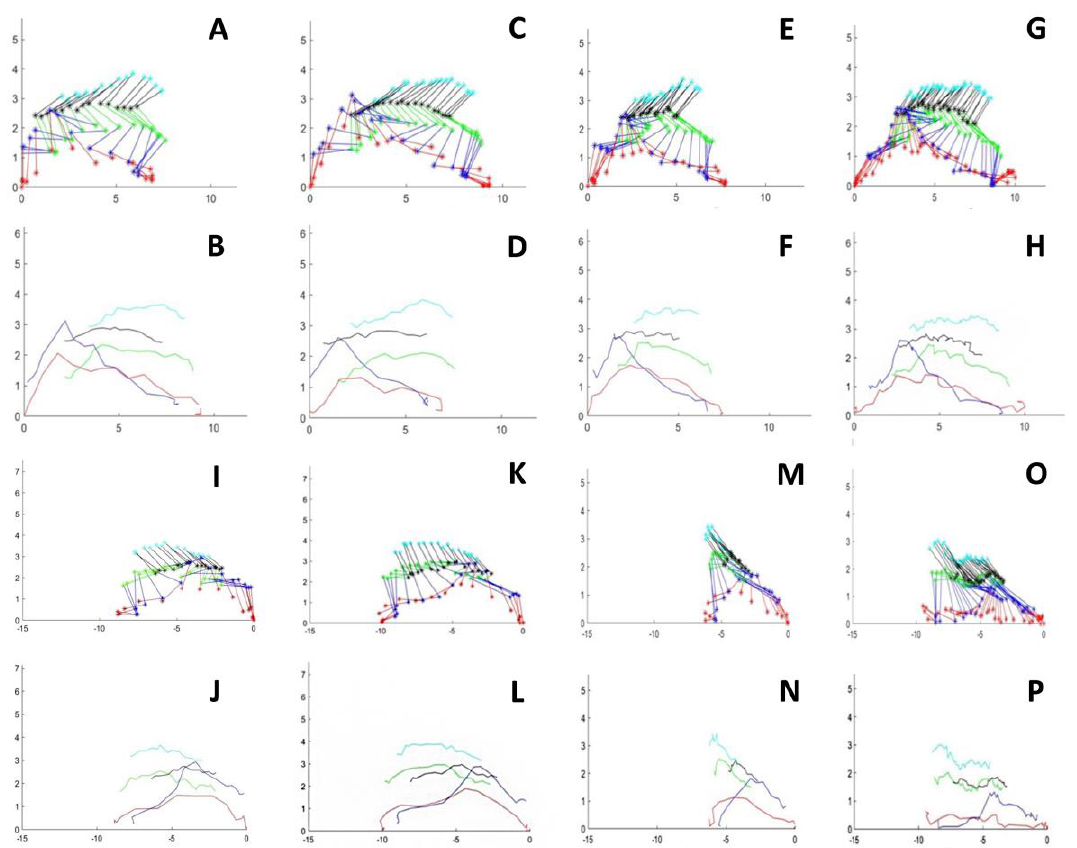
Figure 3. Stick figures of two consecutive steps of the right and left hindlimbs in control and an chronic infected mice. Mouse walking from right o left and viceversa. ( A , C ) Two steps of right hindlimb walking from left to right in a control mouse. ( E , G ) Two steps of right hindlimb walking from left to right in an acute-infected mouse. ( I , K ) Two steps of left hindlimb walking from left to right in a control mouse. ( M , O ). Two steps of left hindlimb walking from left to right in an acute infected mouse. ( B , D ) and ( F , H ) illustrates the linear hindlimb displacement for each marked point in control and in an acute-mice, respectively. ( J , L ) and ( N , P ) Illustrates the linear hindlimb displacement for each marked point in control and in an acute-mice, respectively. Ordenates and abscissas for all graphs are in cm.